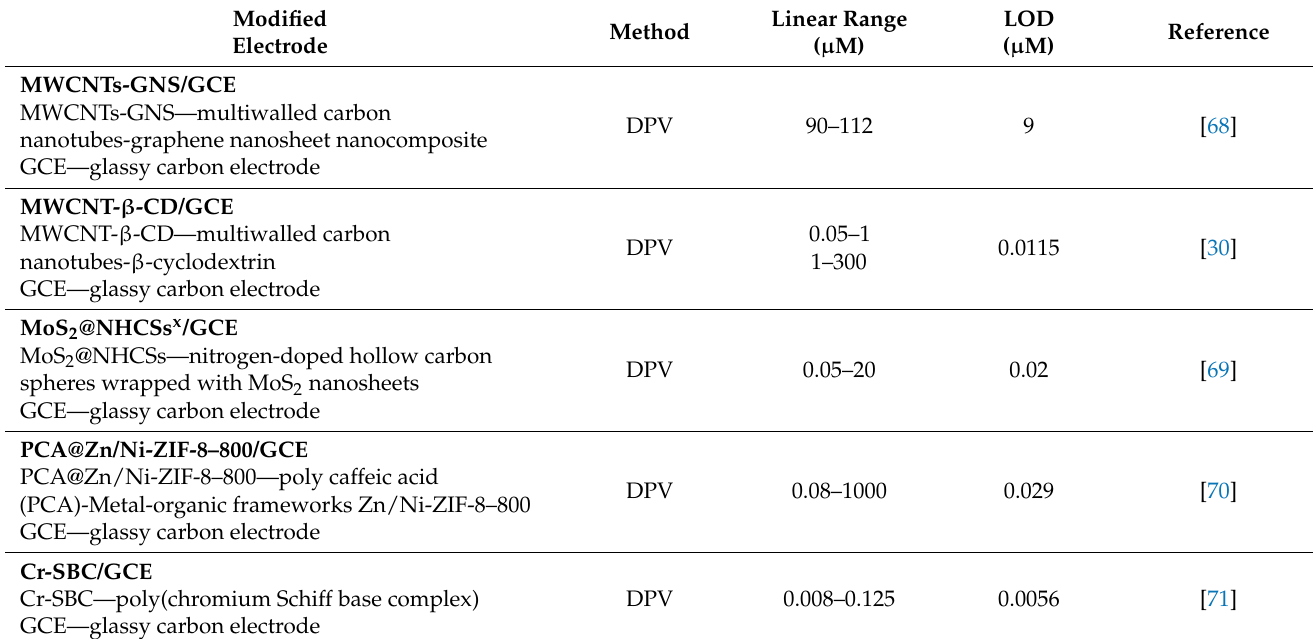
Table 2. Electrochemical performances comparison toward AMP detection for different types of modified electrodes.